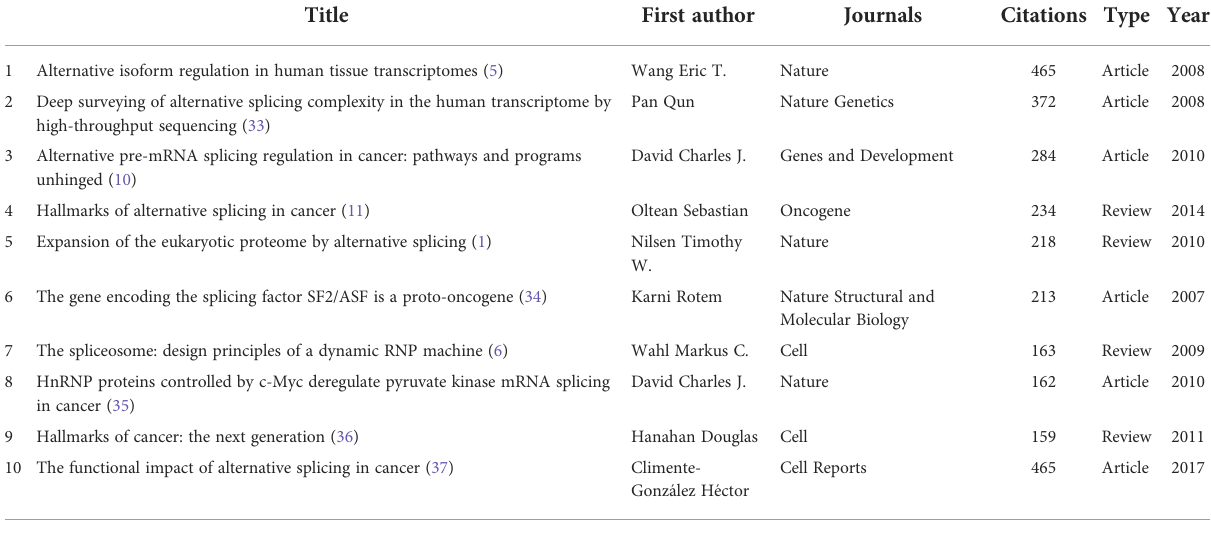
TABLE 4 Top 10 co-cited references related to alternative splicing of cancer.